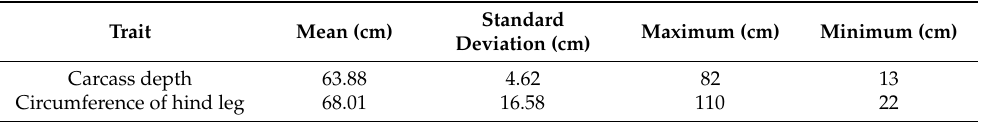
Figure 1. Measurement of hind leg circumference and carcass depth. Table 1. Mean carcass depth and hind leg circumference.